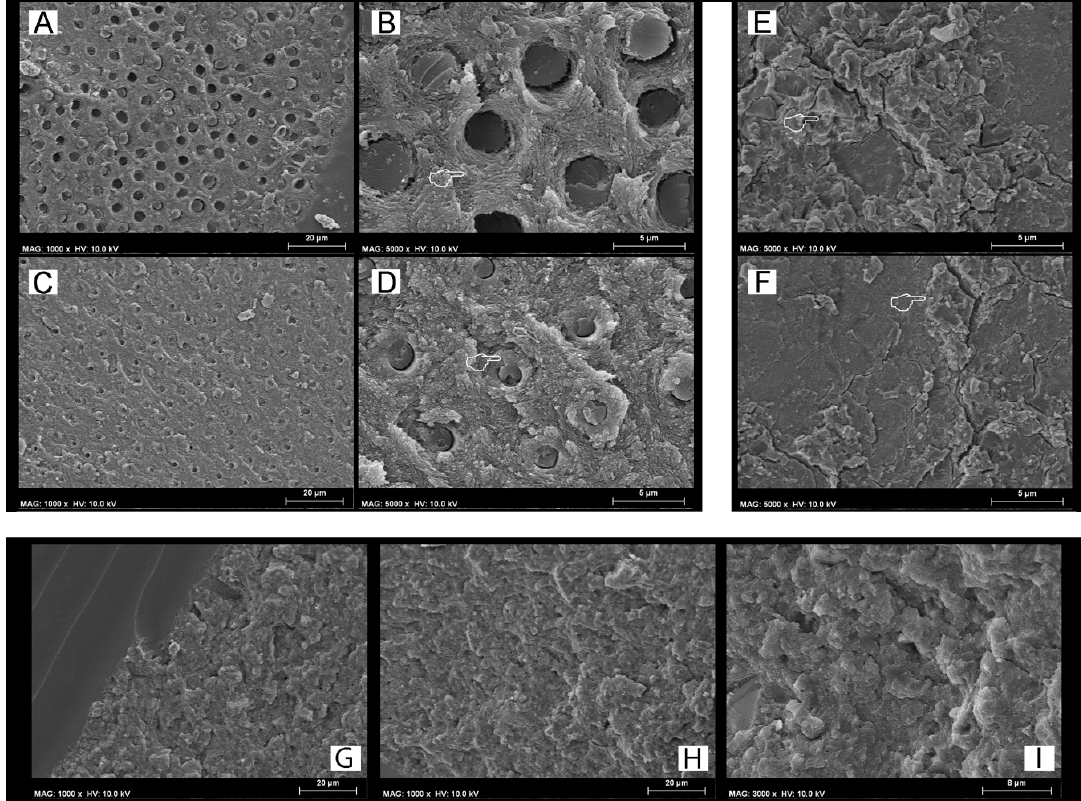
Figure 1. SEM fractographic analysis of the control specimens. ( A ) SEM fractography of a specimen created with SCU applied in ER mode and restored with resin composite (RC) showing the presence of exposed dentine and several resin tags still in the dentinal tubules. ( B ) At higher magnification, it is possible to note the presence of resin tags inside demineralized dentine tubules and collagen fibrils not well infiltrated by the SCU adhesive (pointer). This latter morphological characteristic may indicate that such resin–dentine interface would be affected by degradation over time and would drop in bond strength. ( C ) SEM fractography of a specimen created with FTB applied in ER mode and restored with ACTIVA showing the presence of exposed dentine and several resin tags still inside the small lumen of the dentinal tubules. ( D ) At higher magnification it is possible to observe a typical failure occurred at the bottom of the hybrid layer (HL) characterized by the presence of mineralized peritubular dentine (pointer), with tubules totally obliterated by resin tags and with no presence of demineralized exposed collagen fibrils. Conversely, the dentine specimens bonded with SCU ( E ) and FTB ( F ) applied in ER mode and restored with the RMGIC show the presence of the remaining RMGIC that totally covered the dentine surface. ( G ) SEM fractography of a specimen created with SCU applied in SE mode and restored with ACTIVA and ( H ) FTB applied in SE mode and restored with RC showing a characteristic failure in mixed mode. Note the presence of the remaining resin ( G ) and smear layer on the dentine surface; the latter was even more evident at higher magnification ( I ) .